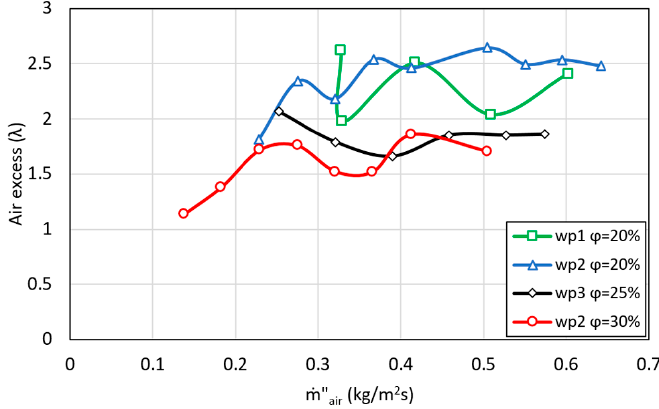
Figure 5. Air excess versus total airflow for different air